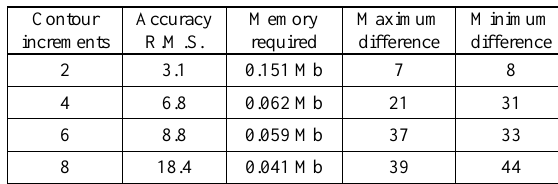
Figure 5. The original image Contour Accuracy increments R.M.S. reconstruct the original image of l